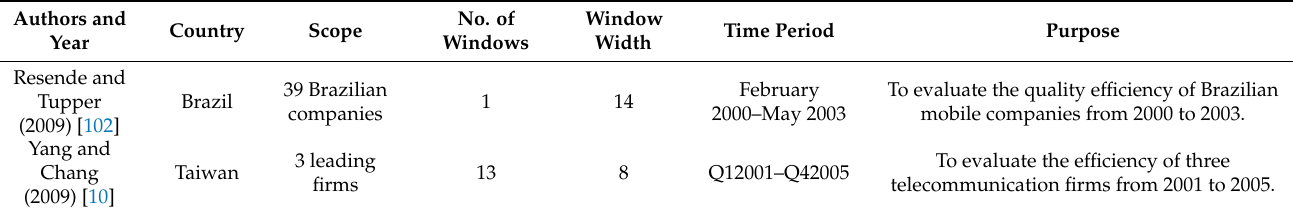
Table 15. Articles classified under the communication category.